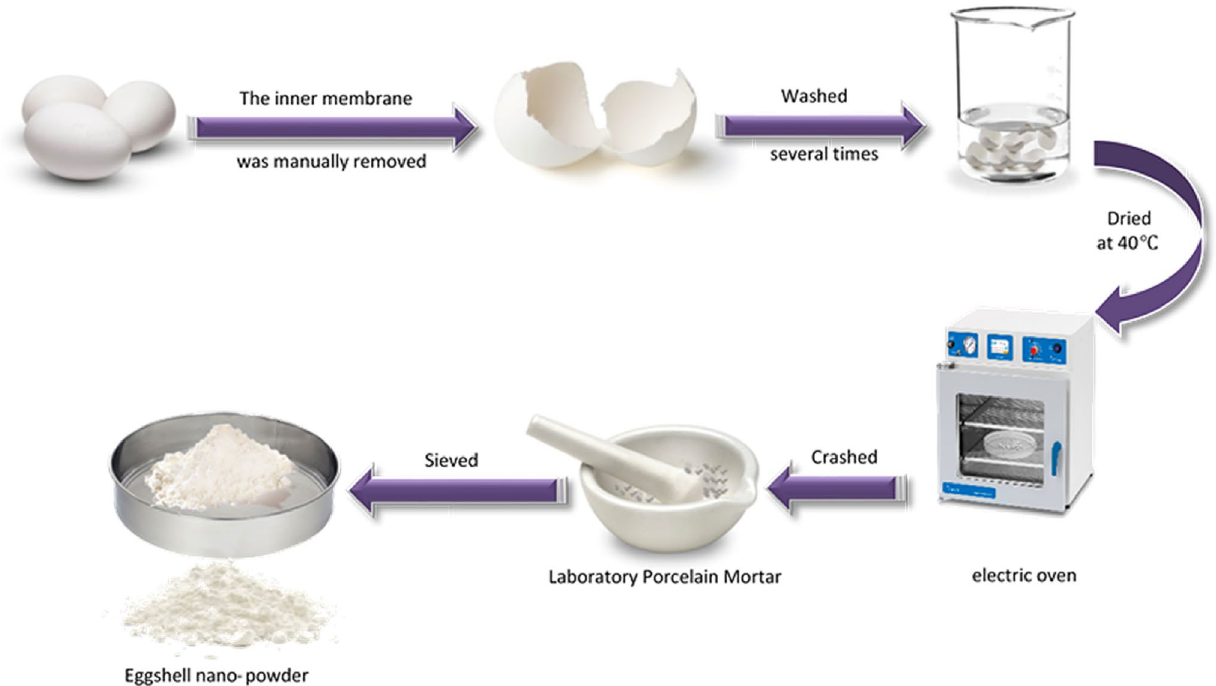
Fig. 1 Scheme of nano-eggshell mechanically